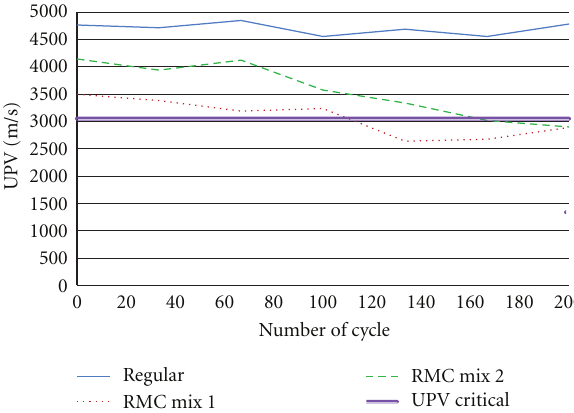
Figure 9: Freeze-thaw resistance using UPV values as a function of cycles.